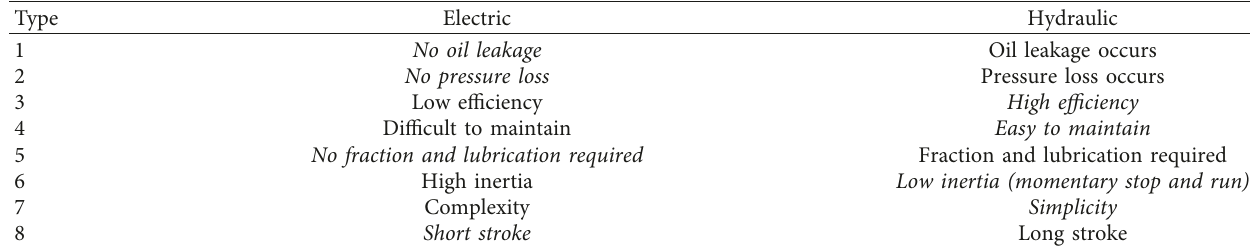
Figure 18. Upon exiting a rod-cut, hulls and pellets are collected directly below the assembly.